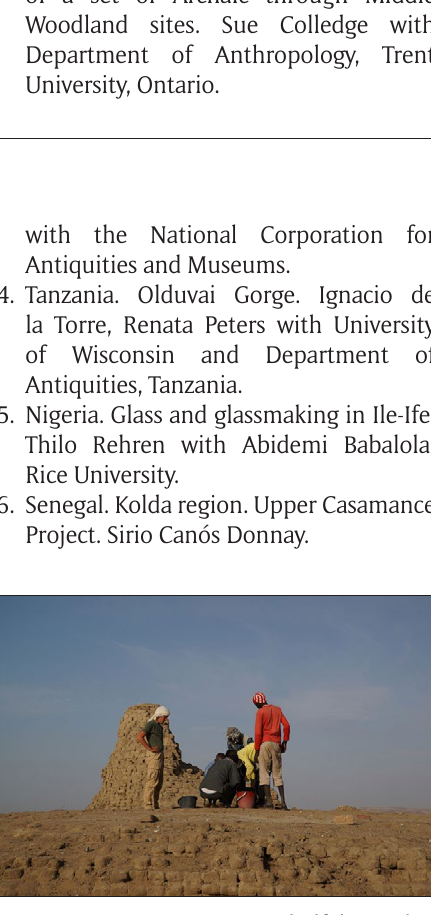
Figure 3: Excavations at Shalfak, Sudan (Photo: Claudia